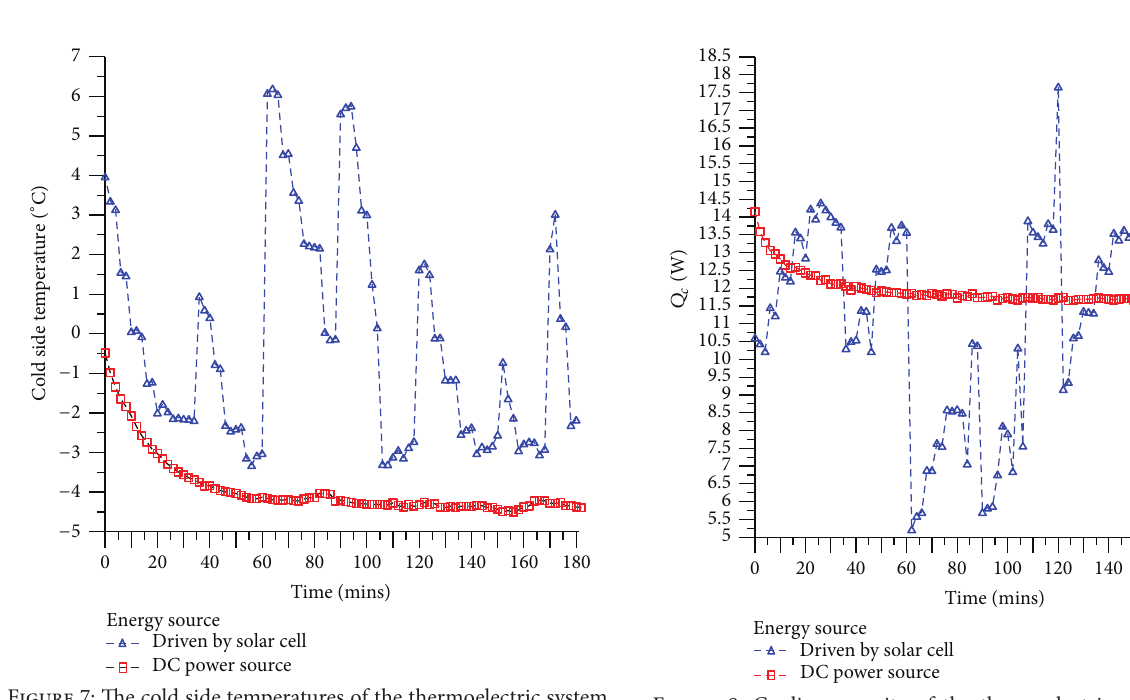
Figure 9: Cooling capacity of the thermoelectric system by DC source and solar cells.